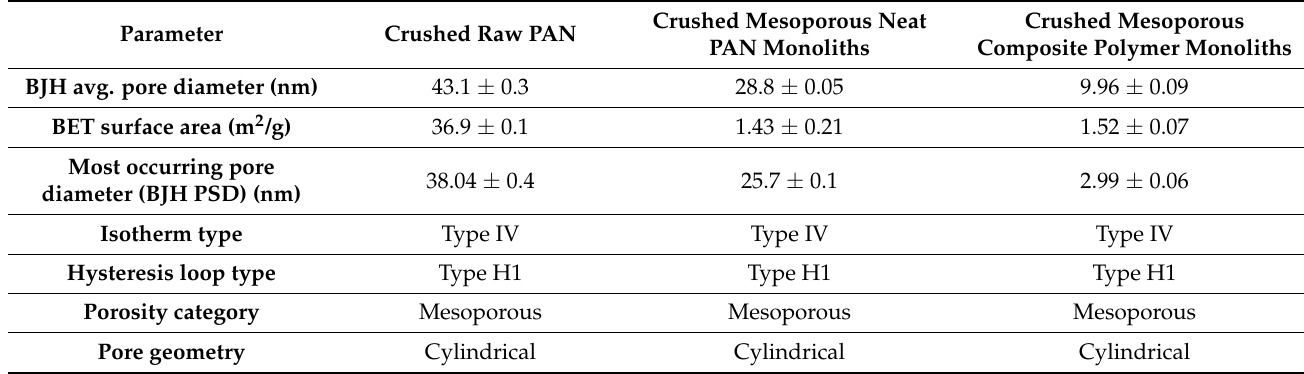
Table 1. A comparison of the surface and pore characteristics of the three polymer materials following BET and BJH analysis of nitrogen adsorption and desorption